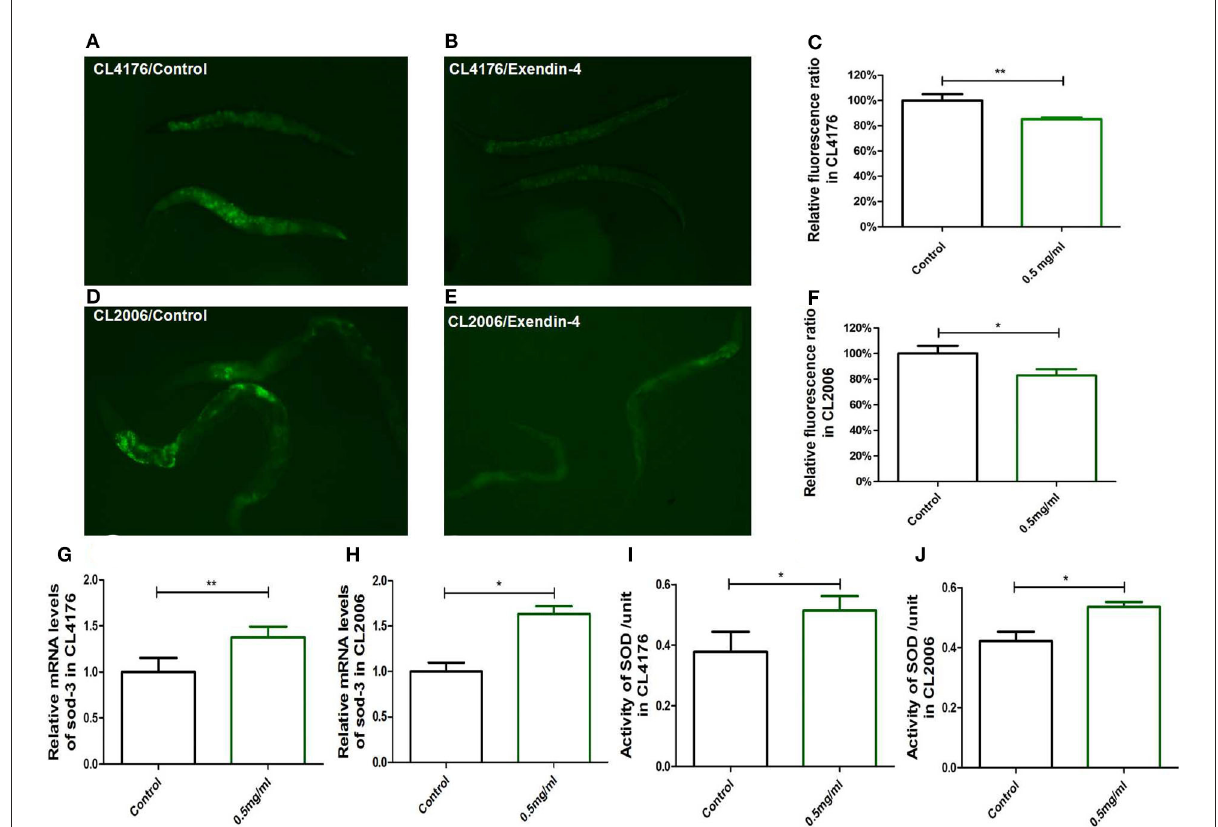
FIGURE6 The effect of antioxidant stress of Exendin-4 in C. elegans CL4176 and CL2006. ROS was analyzed using CM-H2DCFDA. Photographs were taken using a fluorescence microscope at 495nm of excitation wavelength and 537nm of emission filter. (A,D) The untreated CL4176 and CL2006. (B,E) The treated CL4176 and CL2006 with 0.5 mg/ml Exendin-4. (C,F) The fluorescence intensity analyzed using the ImageJ software. (G,H) The mRNA levels of superoxide dismutase-3 (sod-3). (I,J) The activity of sod-3. All the experiments were repeated independently for three times. p < 0.05 ( * ), p < 0.01 ( **